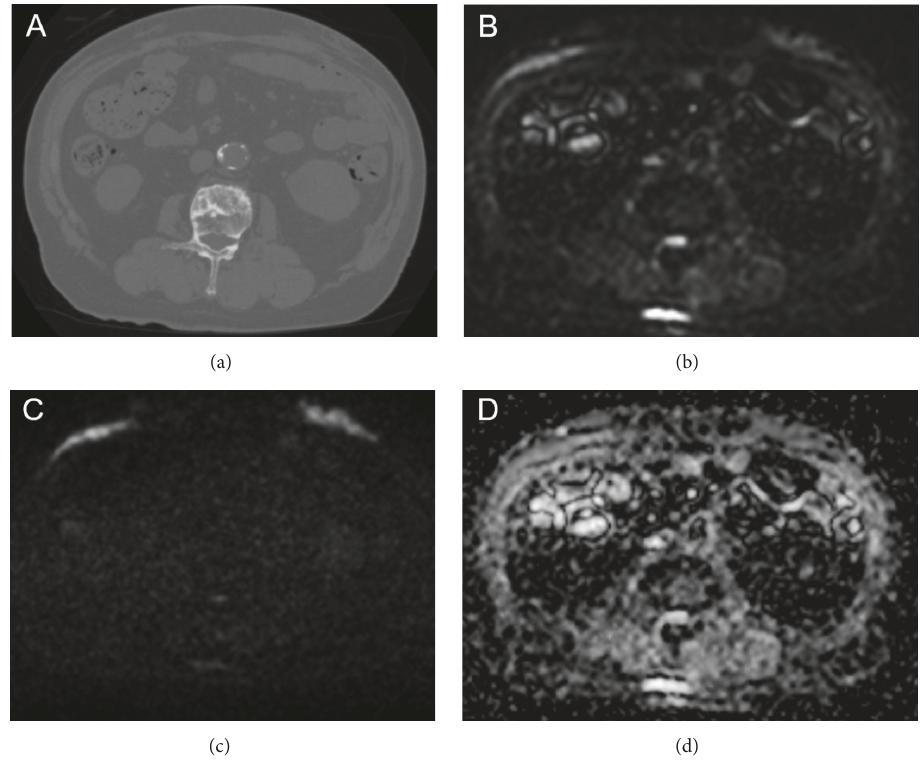
Figure 5: Imaging findings of MRI and CT in the second lumbar vertebra where CT-guided needle biopsy was performed. (a) CT revealed an osteoclastic lesion in the second vertebral body (885.4 HU). 𝑏 = 0 (b) and 𝑏 = 1200 (c) of DWI displayed no high signal intensity in the second lumbar vertebra. (d) The ADC map exhibited low signal intensity in the second lumbar vertebra (the ADC value was 0.498 × 10 −3 mm 2 /s). MRI, magnetic resonance imaging; CT, computed tomography; HU, Hounsfield unit; DWI, diffusion-weighted imaging; ADC, apparent diffusion